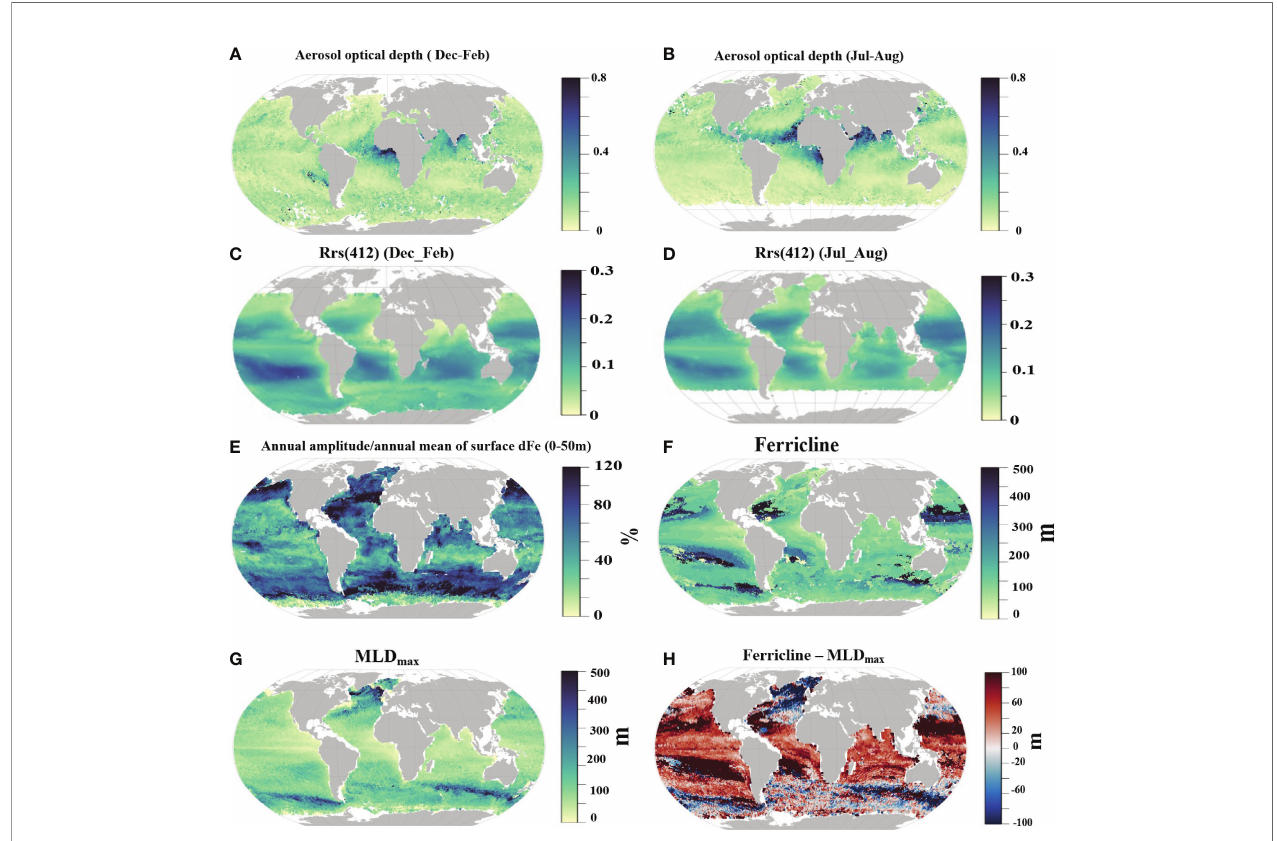
FIGURE 6 | Global distributions of remotely-sensed aerosol optical depth (A, B) , surface optical re fl ectance,Rrs(412) (C, D) , seasonal variability of dissolved Fe represented as the percentage of the annual variance relative to the annual mean, (E) ferricline depth, (F) , annual deepest mixed layer (MLD max ) (G) and the difference in ferricline and MLD max (H)